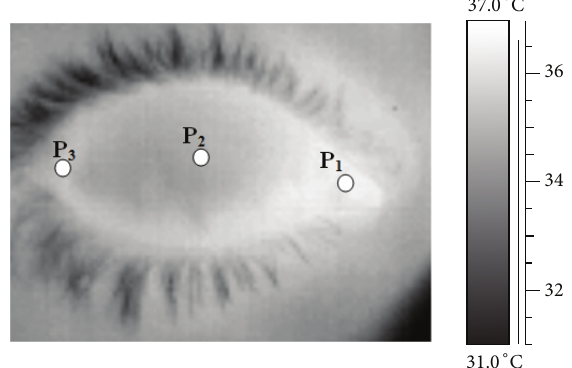
Figure 1: Infrared image of an eye. 1 is nasal cantus, 2 is corneal centre, and 3 is temporal